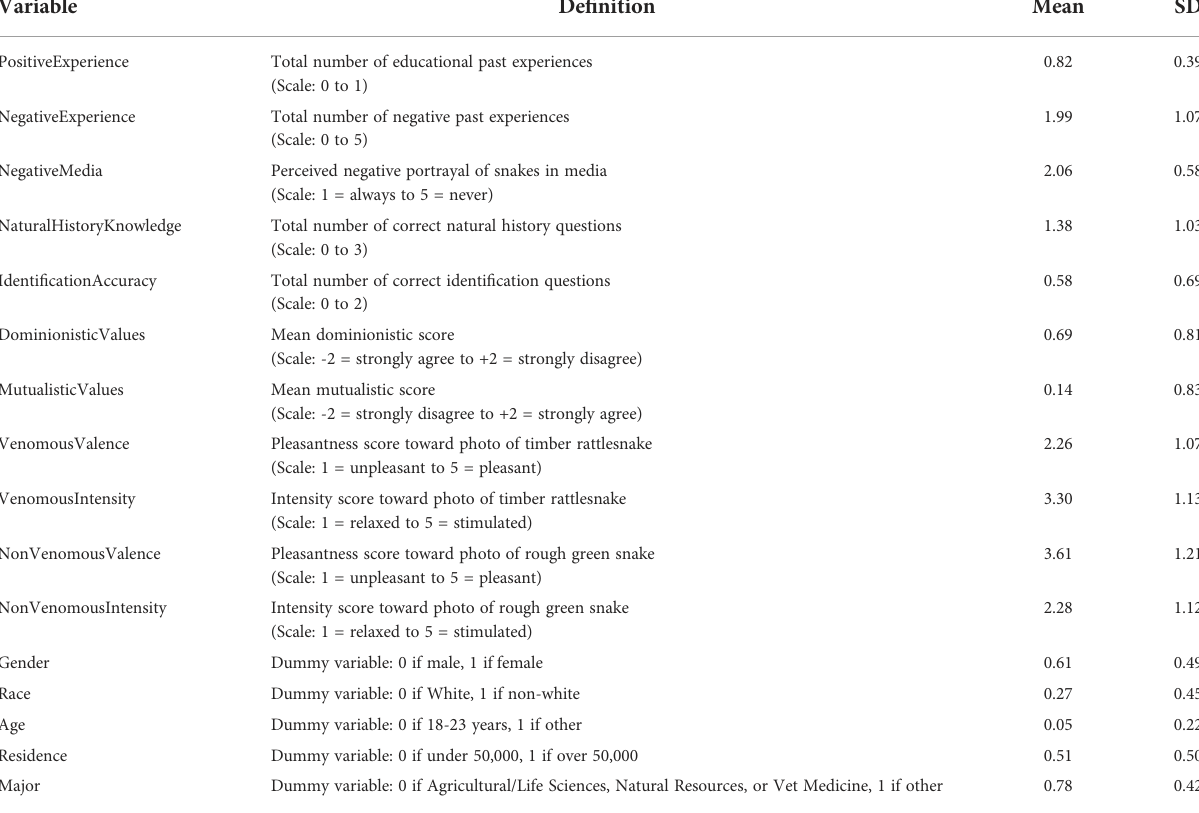
TABLE 1 Variables in multinomial logistic regression model predicting tolerance of snakes among college students in North Carolina, USA (N = 743). Variable De fi nition Mean